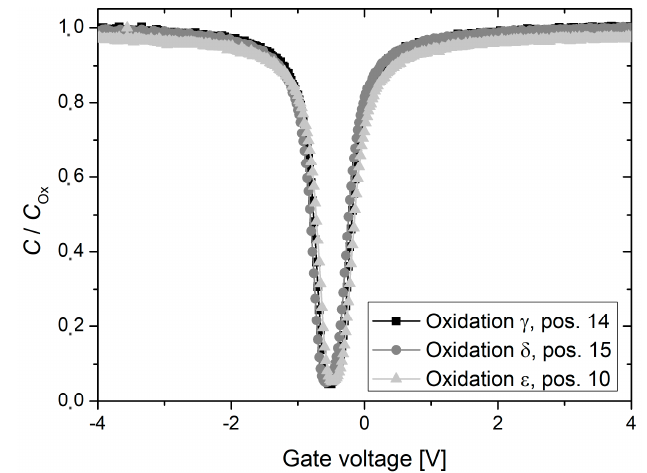
Figure 11. Effective lifetime as a function of the optical generation rate measured in the center of wafers, which were extracted from oxidation run ε , and placed in quartz boat positions 6, 12, and 18, respectively. Quartz boat position 18 is located in direction of the tube door.